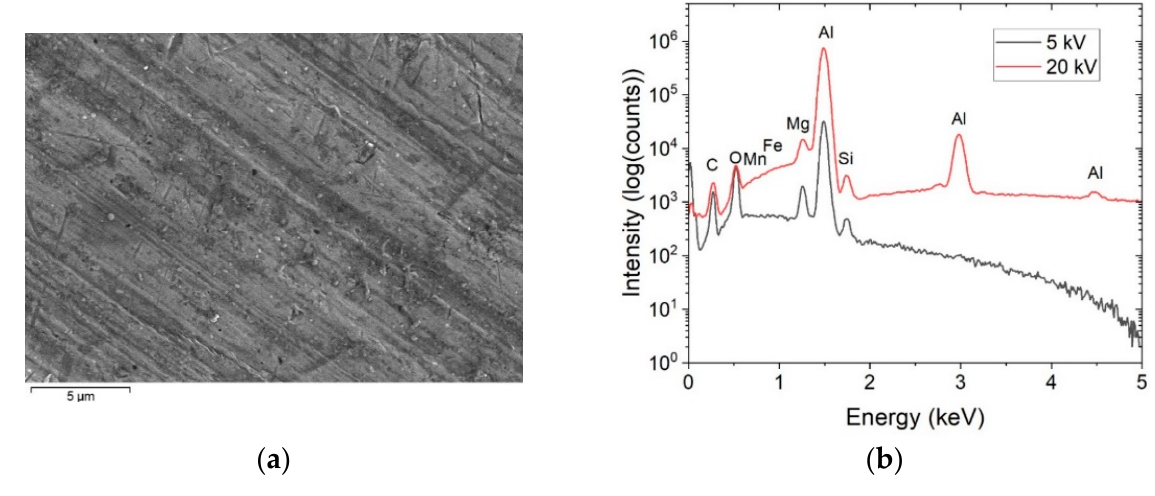
Figure 2. SEM analysis of unpolished Al6082 aluminium plate surface: ( a ) × 5k magnification image; ( b ) EDS analysis of the sample by using a 5 kV and 20 kV acceleration potential at a magnification of × 100.